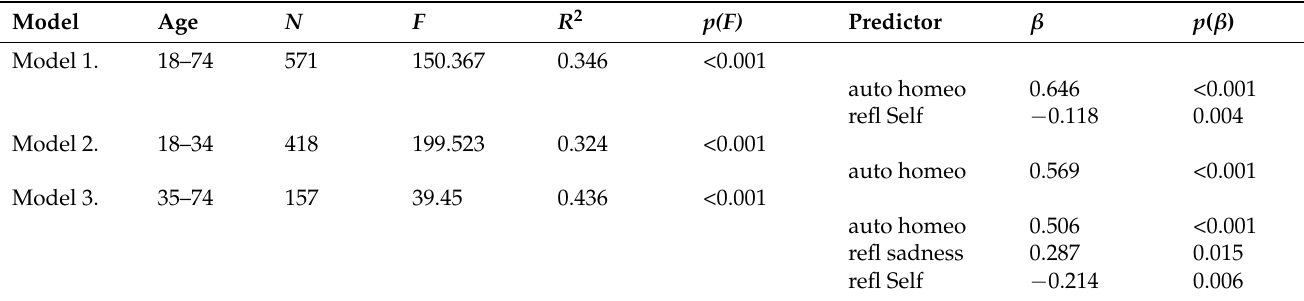
Table 2. Regression models differ with the age of participants and statistically significant predictors of the feeling of threat caused by the pandemic. Emotion categories: auto homeo = automatic homeostatic emotions; refl Self = reflective emotions related to Self; refl sadness = sadness-like reflective emotions not related to